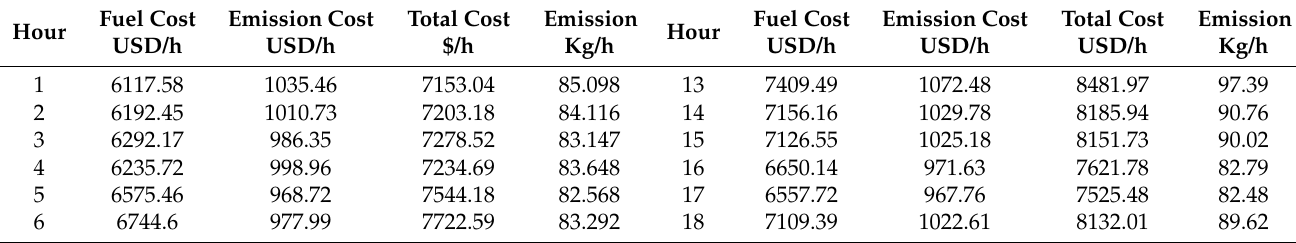
Table 4. Table of costs and emissions for 24 h—case study